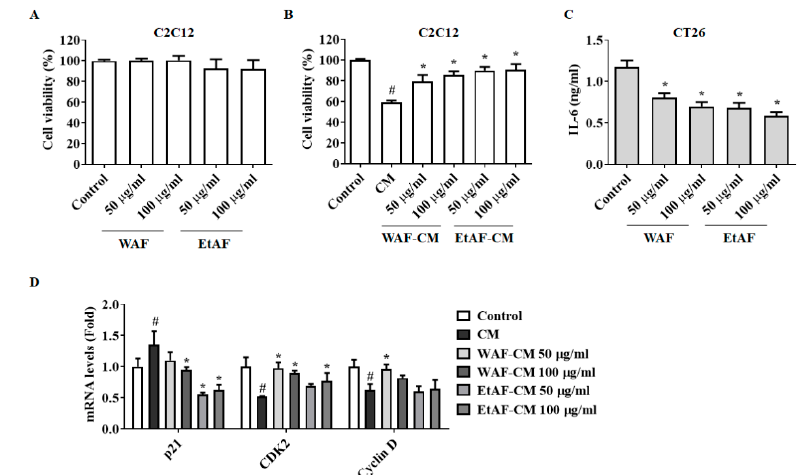
Figure 7. Effects of AF on cell viability and cell cycle arrest of C2C12 myoblast treated with conditioned media (CM) from CT-26 cells. C2C12 myoblasts were treated with WAF and EtAF for 48 h, and then cell viability was determined ( A ). C2C12 myoblasts were incubated with CM treated with or without WAF and EtAF after 50% dilutions in differentiation media. After 36 h, cell viability was measured ( B ). IL-6 secretion from WAF and EtAF-treated CT-26 cells ( C ). Using CM-treated C2C12 cells, qPCR and Western blot were conducted. mRNA levels of cell cycle related factors were measured ( D ). GAPDH was endogenous control. Results are from three independent experiments. All values are mean ± SD. # p < 0.05, significantly different from control group; * p < 0.05, significantly different from CM group.